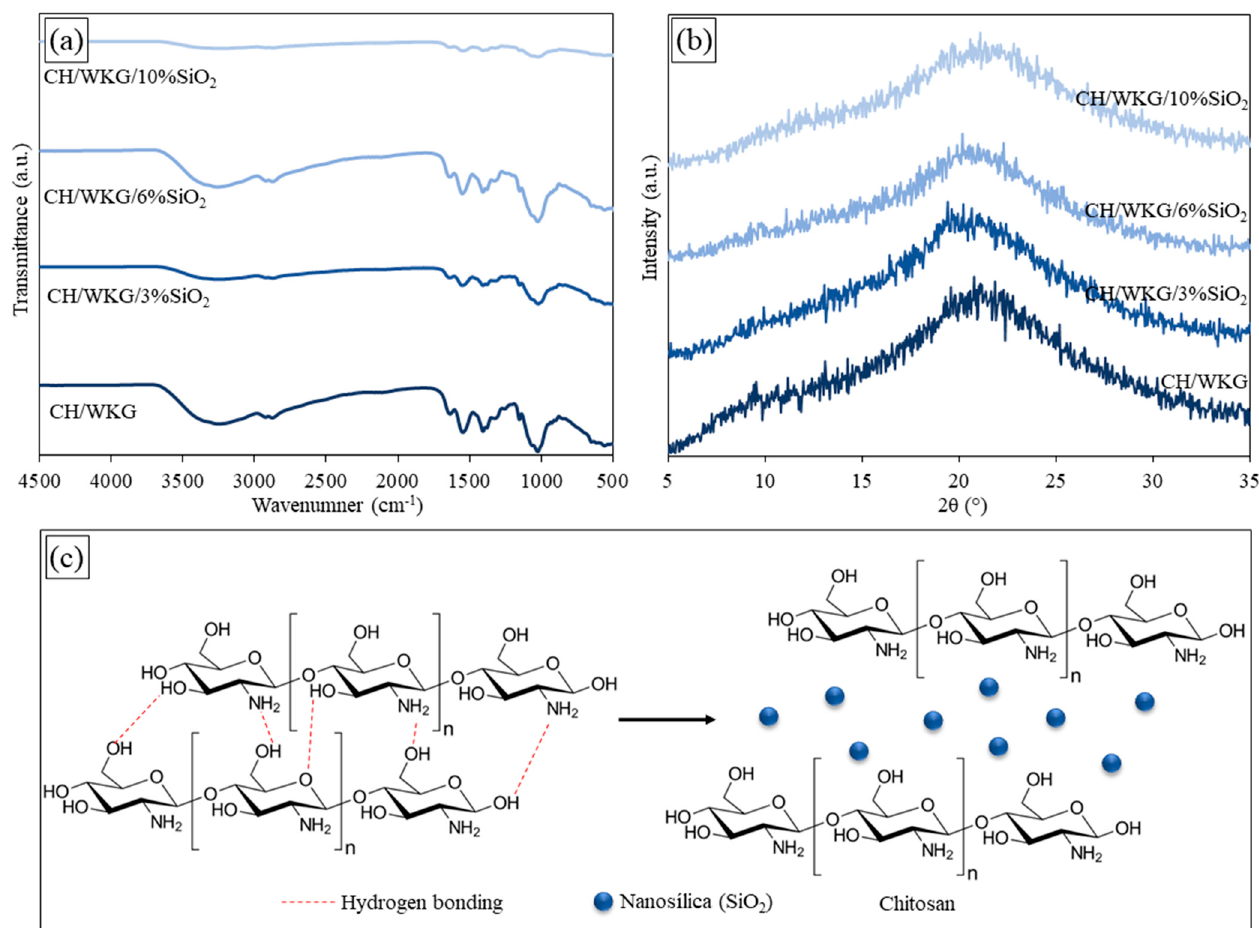
Figure 2. ( a ) FTIR spectra, ( b ) DRX patterns of the CH/WKG film and the samples incorporated with different proportions of nanosilica, and ( c ) simplified scheme of the possible effect of macromolec-